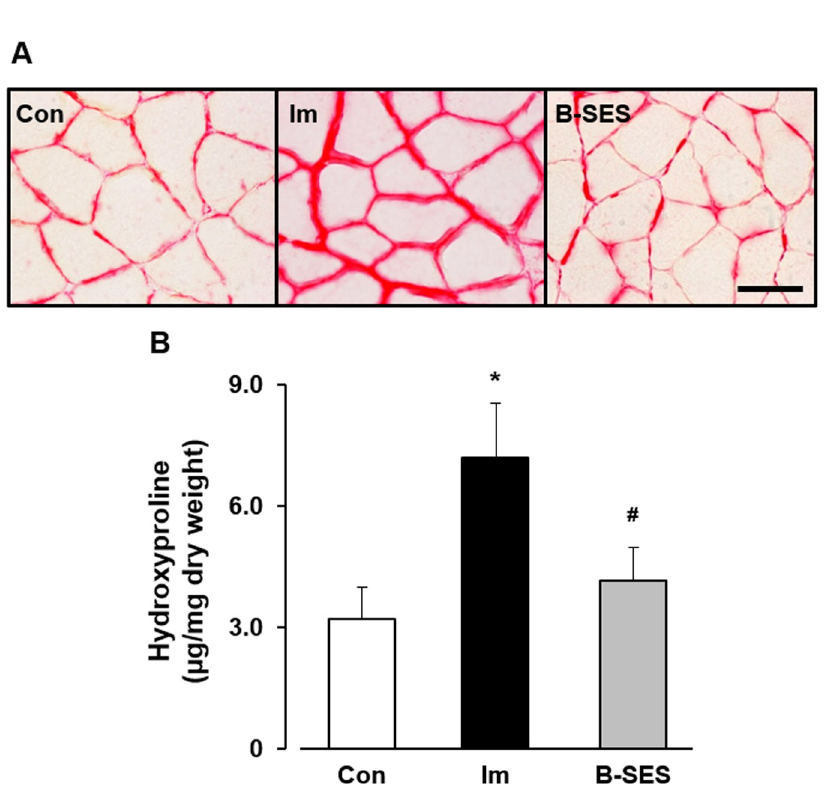
Fig 8. Picrosirius red imaging(A) and hydroxyproline expression (B) in soleus muscles. Scale bar, 50 μ m.Open bar represents the control group (Con). Black bar represents the immobilization group (Im). Gray bar represents the belt electrode-skeletal muscle electrical stimulation group (B-SES). Data presented as mean ± standard deviation. � , Significant difference (p < 0.05) compared with the control group. #, Significant difference (p < 0.05) compared with the immobilization